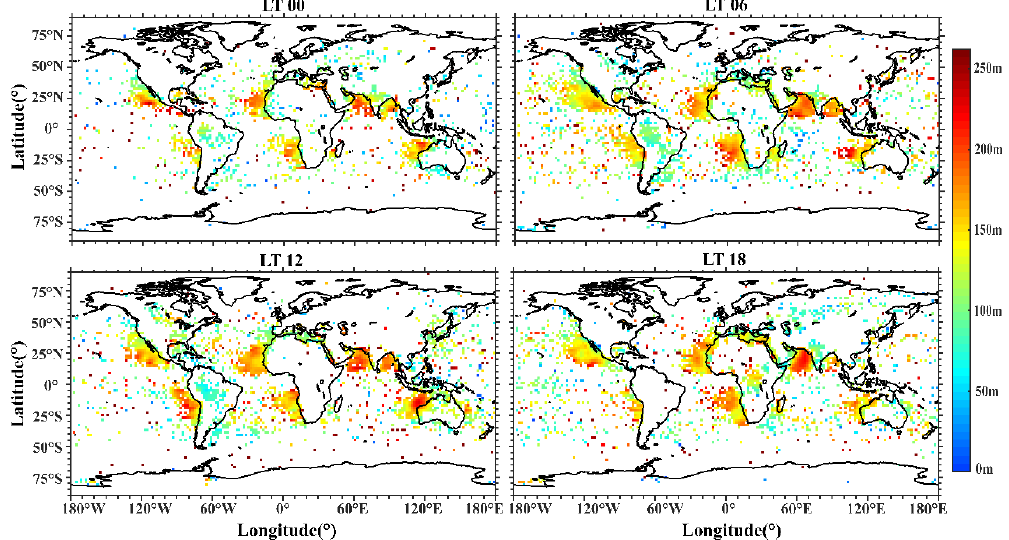
Figure 12. Distribution of the trapping layer thickness with local time variations. The blank grids represent that there is no trapping layer event.